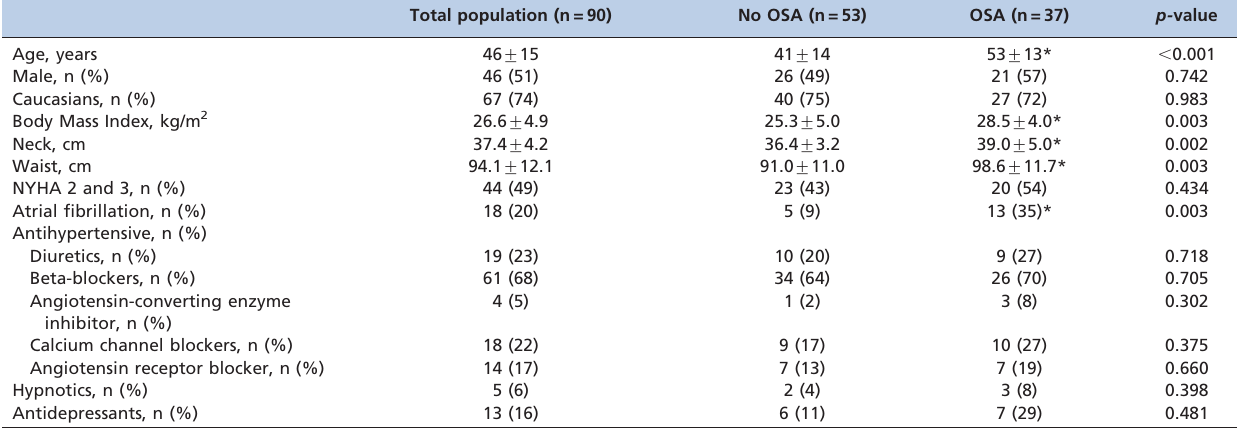
Table 1 – General and clinical characteristics of the entire population of patients with hypertrophic cardiomyopathy and the patients with and without obstructive sleep apnea.